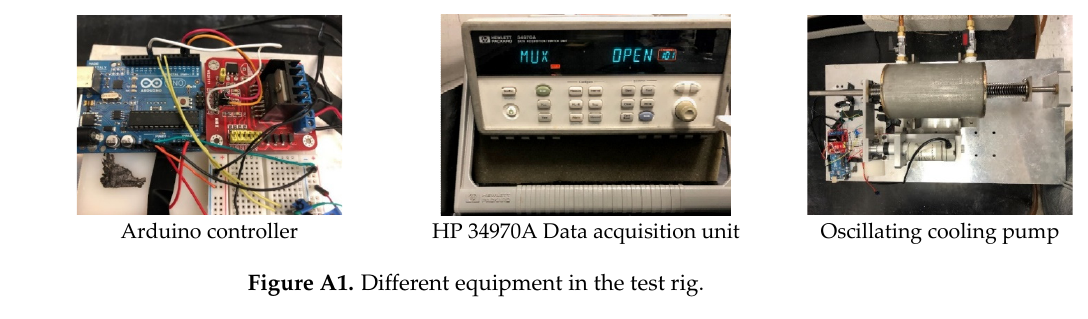
Figure A1. Different equipment in the test rig.